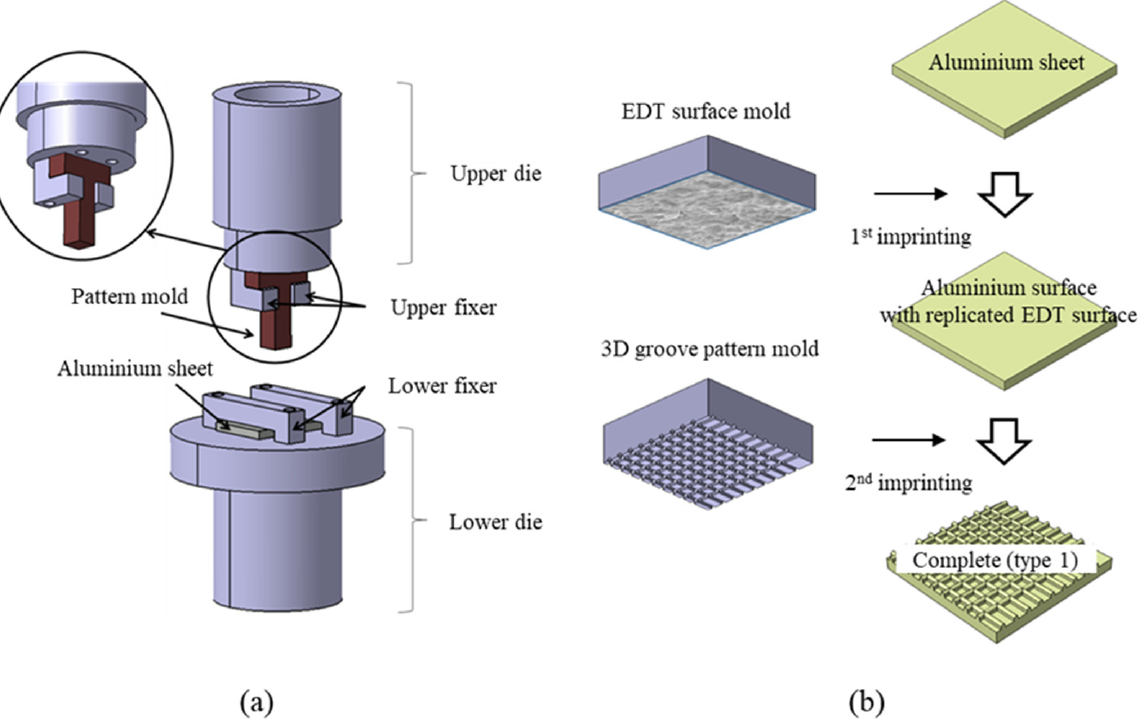
Figure 1. Schematics depicting ( a ) imprinting die-set and ( b ) two-stage imprinting processes. Figure 1b shows the sequence of the imprinting process. The imprinting is performed in two steps. In the 1st imprinting, the rough electrical discharge texture (EDT) surface is duplicated on the aluminum surface using an EDT surface mold. Thereafter, the groove pattern is replicated using a 3D groove pattern mold in the 2nd imprinting. Through these imprinting processes, the hierarchical pattern is formed on the aluminum surface. Here, the EDT surface mold is the mold in which a rough discharge surface is formed on the mold surface fabricated by EDM, and the 3D groove pattern mold refers to the mold in which the groove pattern is formed on the mold surface fabricated by wire electrical discharge machining (WEDM). This study was carried out by applying a 3D groove pattern mold having a pitch of 600 µ m. Detailed information on each mold shape and process can be found in the reference [29]. Figure 2 shows the surface of the aluminum specimen fabricated through imprinting. As shown in Figure 2a, the pattern surface is divided into peaks and valleys, and each surface roughness was measured as Ra equal to 10.0 µ m and 2.5 µ m, respectively. The